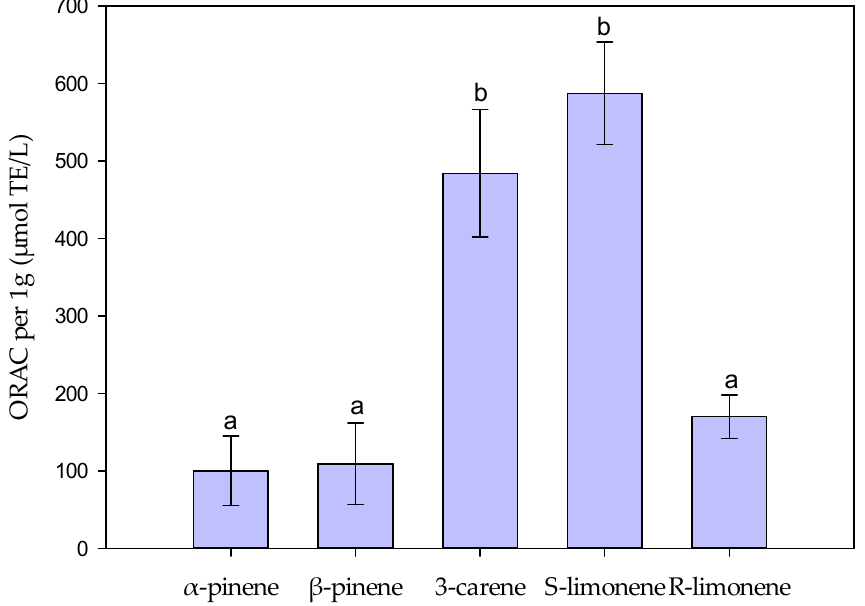
Figure 5. Oxygen radical absorbance capacity (ORAC) results of 1 g of α - and β -pinene, 3-carene, and S- and R-limonene. 3-Carene and S-limonene indicated the highest antioxidant activities of the tested monoterpenes. The values represent the µ mol Trolox Equivalent (TE) averages ± standard deviations (sample size = 4) from 1 g of monoterpenes. The letters above the bars indicate significant differences between the means of the groups ( p value < 0.05) evaluated by one-way analysis of variance (ANOVA) completed with Tukey’s test.